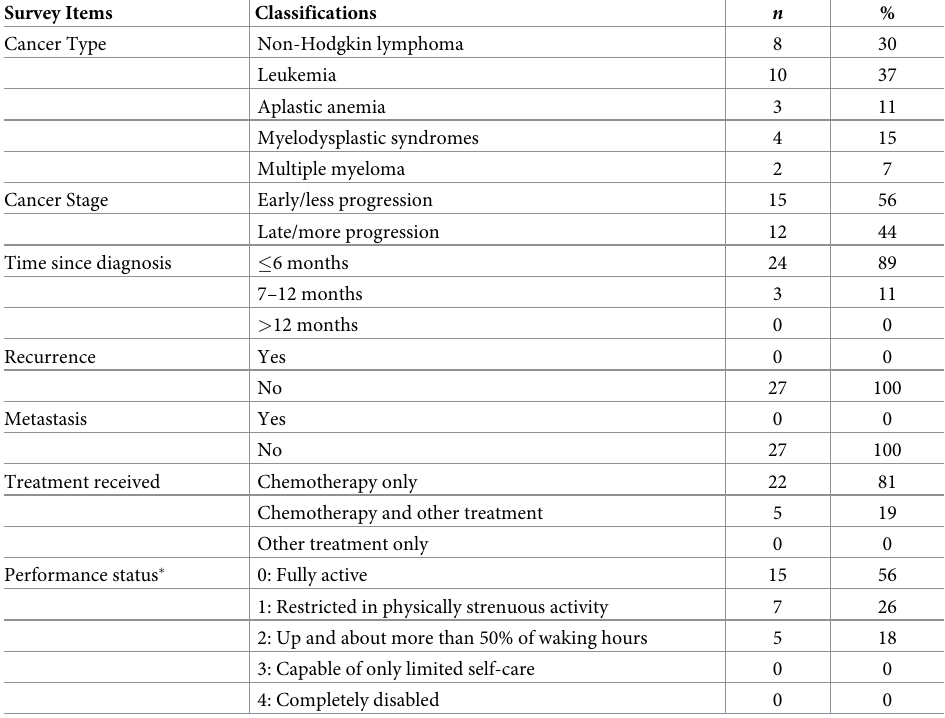
Table 2. Disease and treatment characteristics of participants. Survey Items Classifications n Cancer Type Non-Hodgkin lymphoma Aplastic anemia Myelodysplastic syndromes Multiple myeloma Cancer Stage Early/less progression Late/more progression Time since diagnosis (cid:20) 6 months